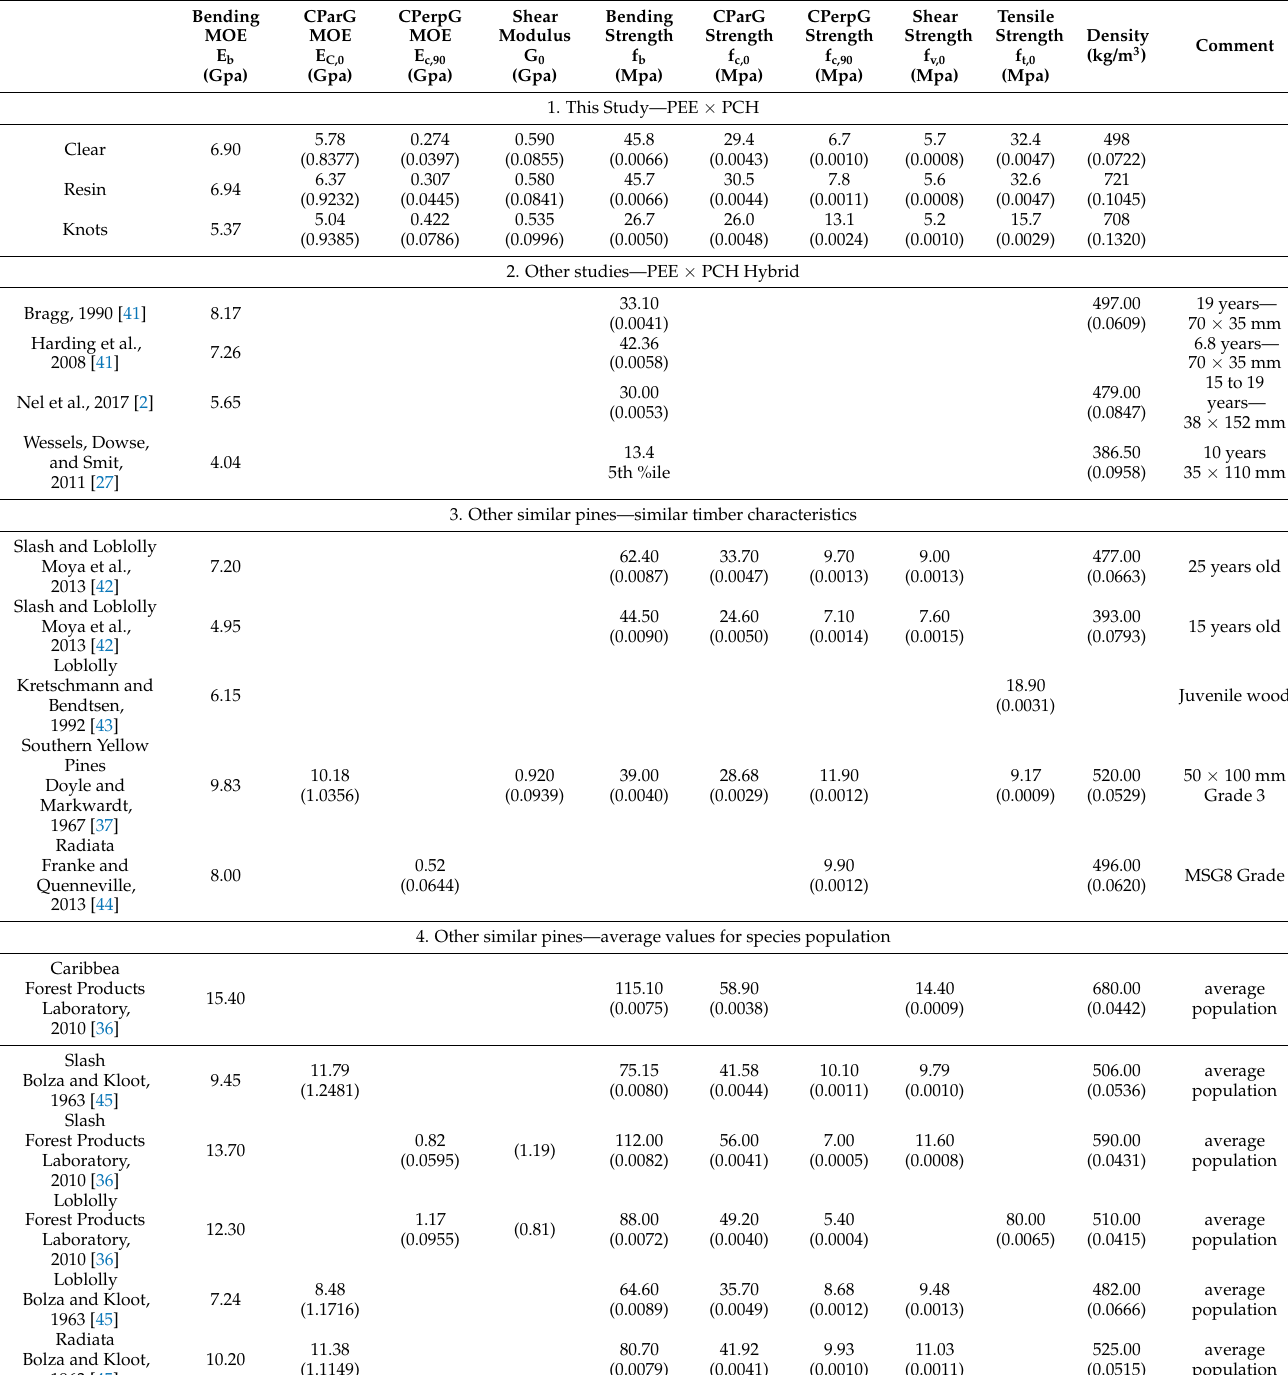
Table 3. Average properties for similar species of pines and their ratios to bending